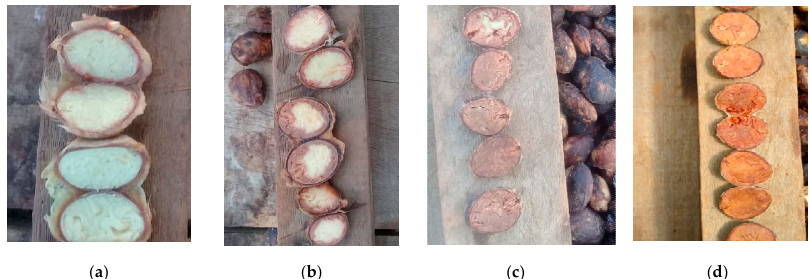
Figure 8. Pictures displaying the color evolution of ( a ) freshly pulped seeds, ( b ) on the third day of fermentation, ( c ) from the third day of fermentation on, and ( d ) fermented and dried beans. Courtesy of the authors J.M.L.S., C.B.C.C., S.K. and M.A.M.V. Rio Branco, Acre, Brazil.